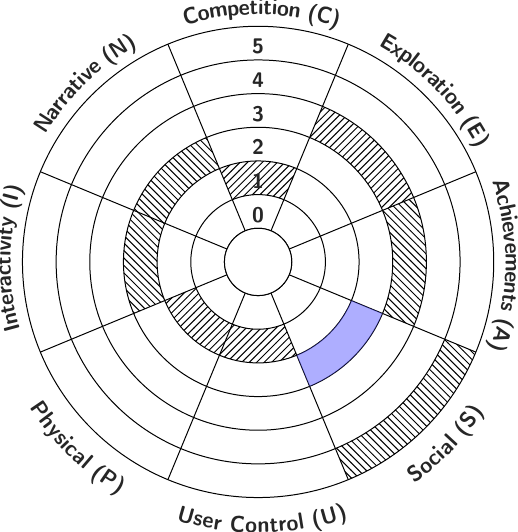
Figure 3. The hatched fields show the Engagement Profile of a generic learning trail. The shaded field indicates the Social dimension value when the learning trail is performed as a single visitor instead of in a